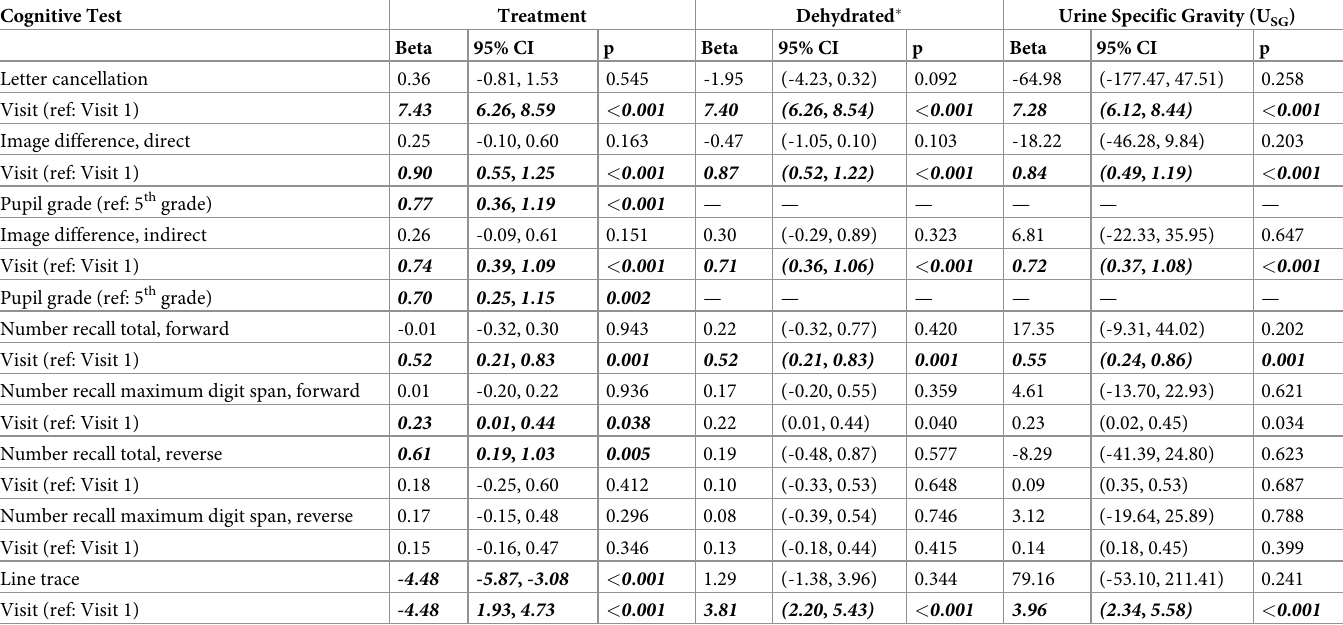
Table 3. Mixed effects linear regression models of associations between treatment group, afternoon measures of hydration, and cognitive performance (n = 107). Cognitive Test